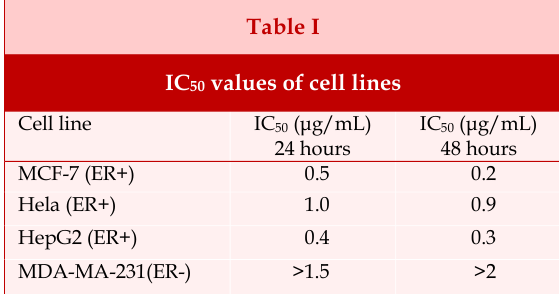
IC 50 values of cell